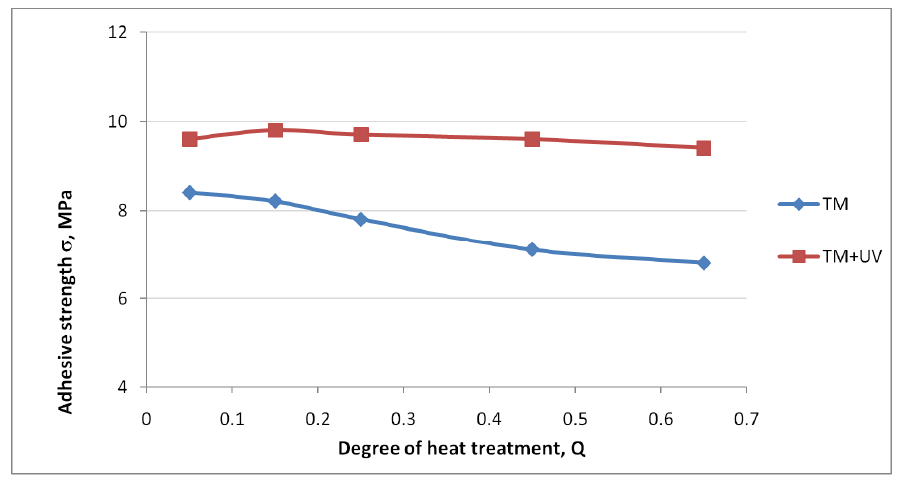
Figure 9. Shear strength tests.